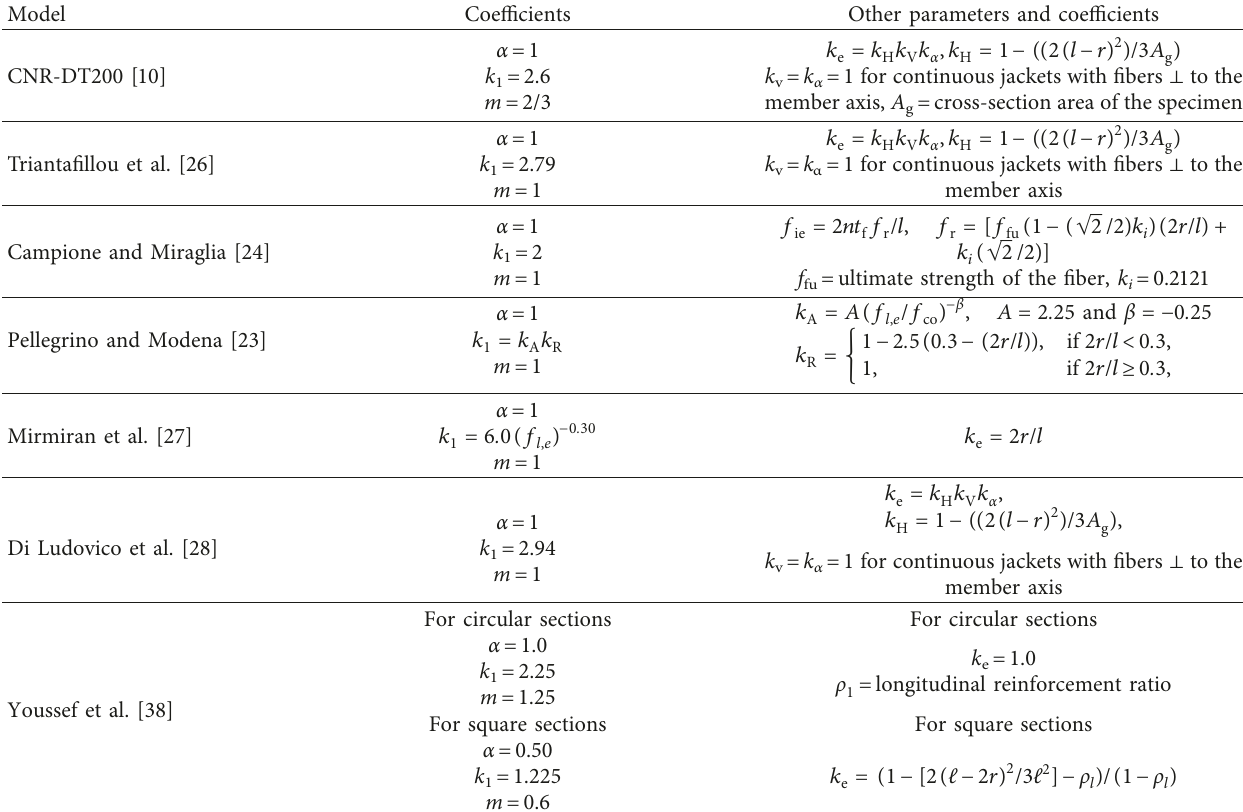
Table 4: Parameters and coefficients for evaluating the strength enhancement from existing analytical expressions.